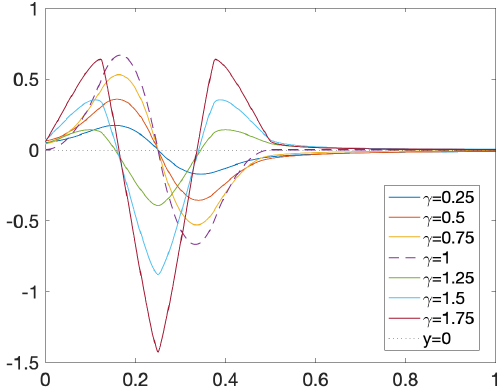
Figure 2. The Riesz–Caputo derivative of the cubic B-spline B 3 (see Appendix B) for different values of the fractional order γ , with 0 < γ <